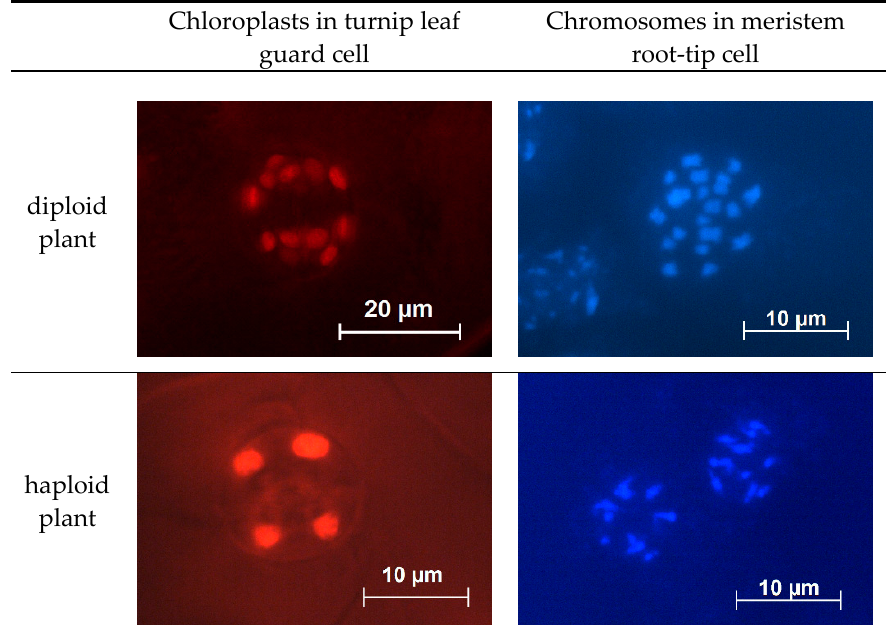
Figure 5. Chloroplast and chromosome numbers in cells of haploid and diploid turnip plants. Ploidy levels of plantlets were determined, and a high frequency of diploids was shown in all 0.05 mg/L (Table 4)